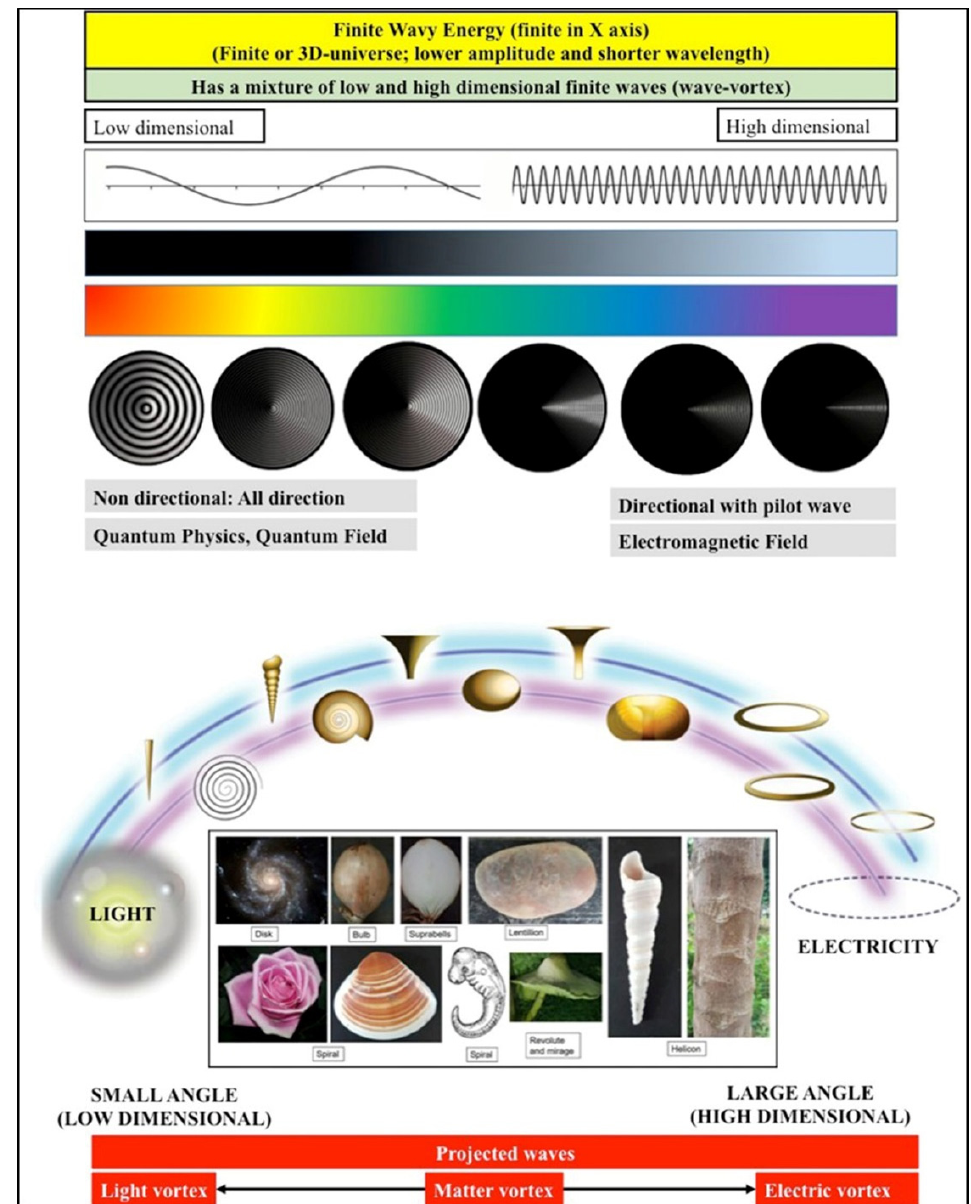
Figure 3. Illustration of further details on the low- and high-dimensional fields of our finite uni-verse. The intersection of higher and lower light creates light, electricity, and matter vortices. The light vortex is created by a small angle of interception, whereas electricity is created by a large angle of interception. Matter vortices are formed by the angles in between. Any light is regarded as low-dimensional and nondirectional, diffused, changing, or delocalized, whereas electricity is considered high-dimensional and directional with features of pilot waves, i.e., it is a locatable, deterministic, specific network that may follow Bohmian mechanics.